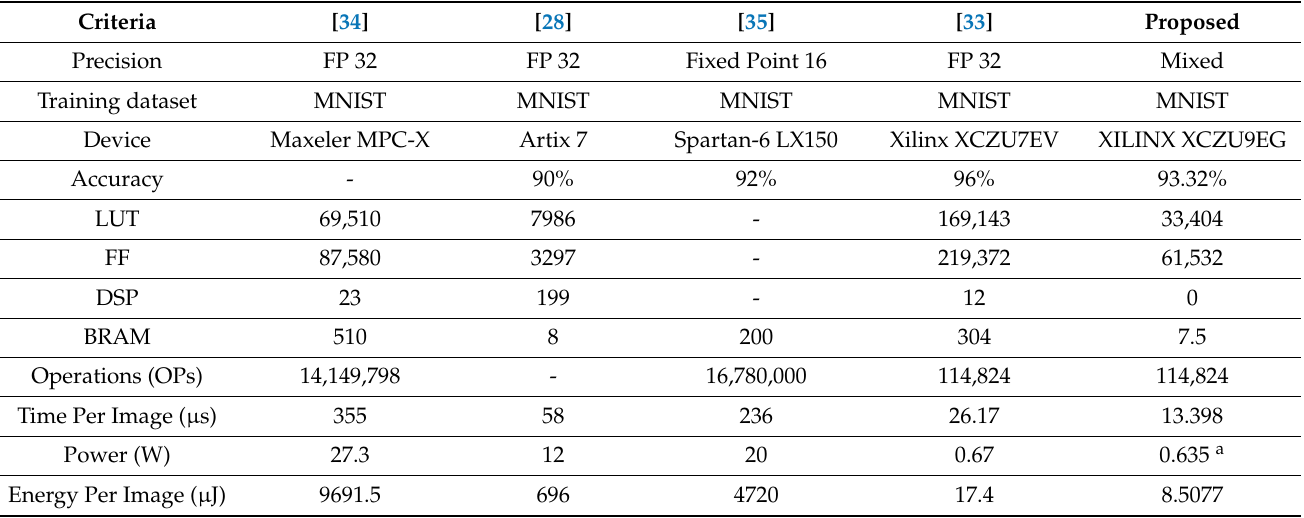
Table 8. Comparison with other related